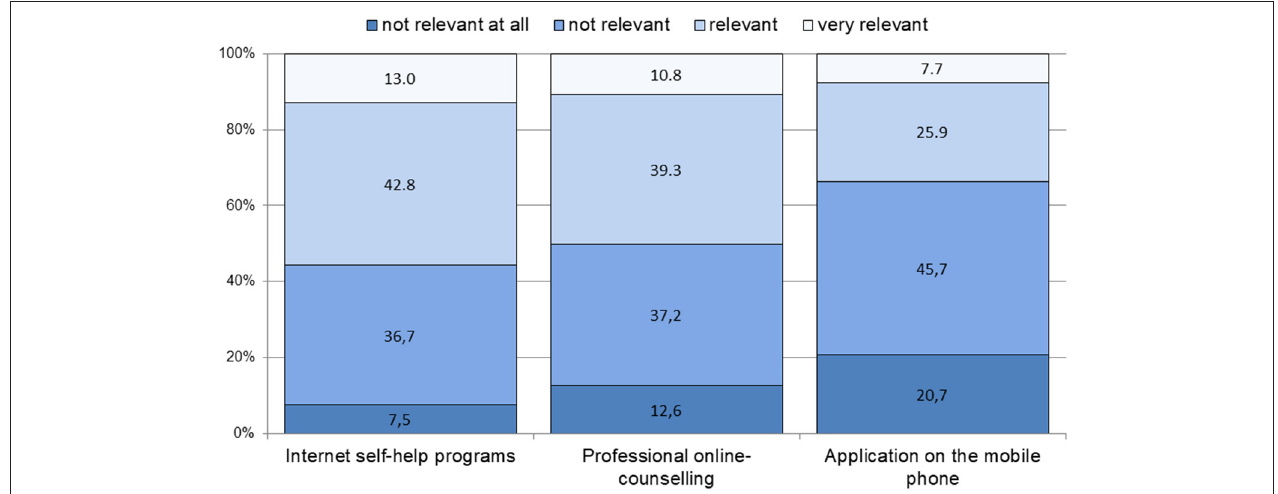
FIGURE 2 | Use of mental health applications as a prevention strategy to prevent common mental disorders: attitudes toward relevance. Single items: frequency of answers on a 4-point Likert scale from 1 “not relevant at all” to 4 “very